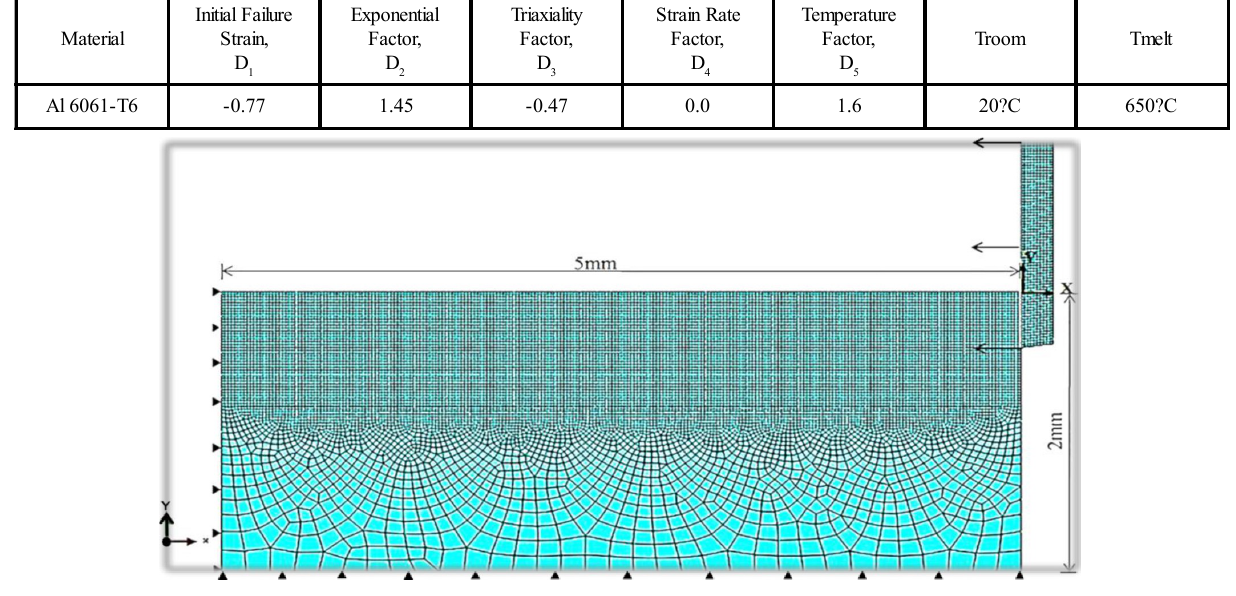
FIG. 8. FINITE ELEMENT MESHING AND BOUNDARY CONDITIONS SHOWING FIXED WORKPIECE AND TOOL VELOCITY GIVEN ALONG X-AXIS